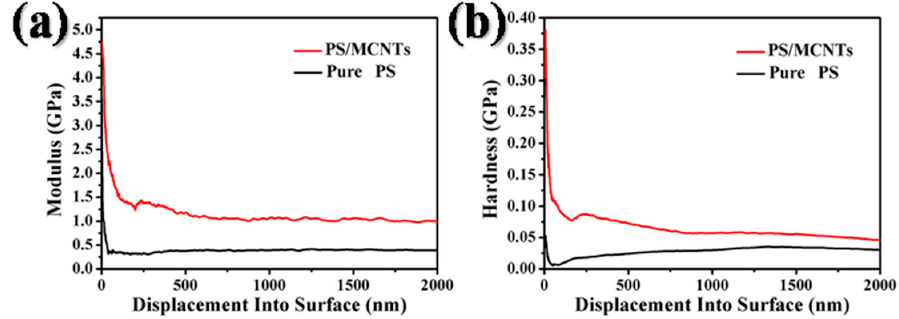
Figure 5. ( a ) Curves of modulus for the PS/MWCNTs and pure polystyrene (PS) films as a function of displacement into surface (nm); ( b ) Curves of hardness for the PS/MWCNTs and pure PS films as a function of displacement into surface (nm); The test sample was the red film.